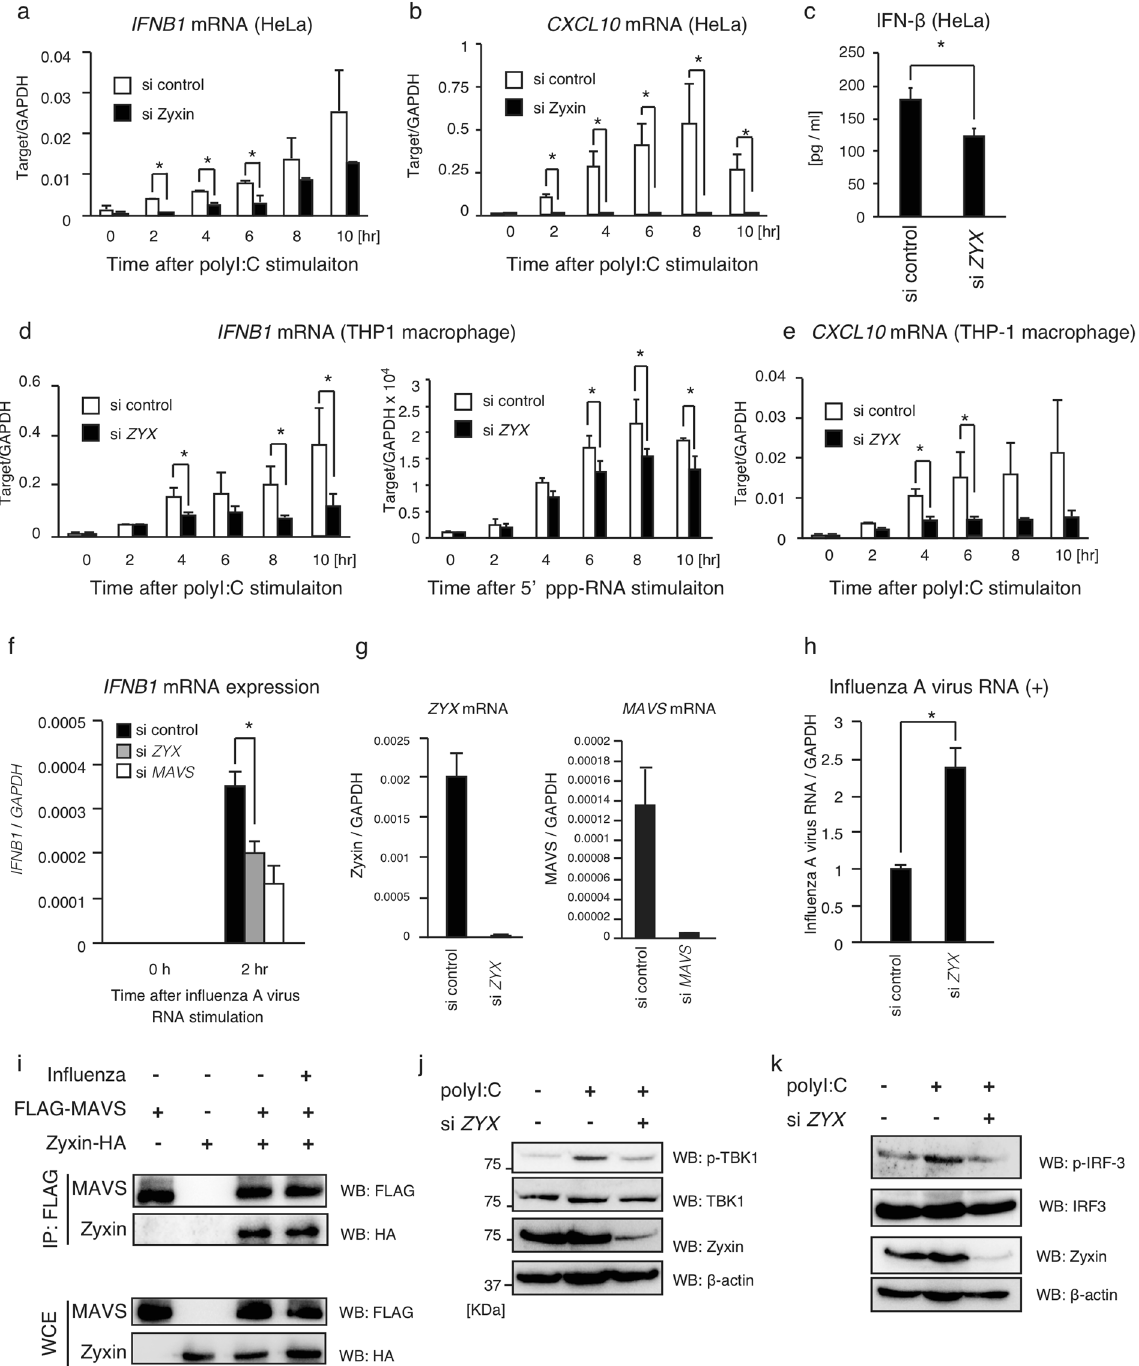
Figure 4. Zyxin is involved in a type I IFN expression pathway. ( a , b ) siRNA for ZYX or negative control were transfected into HeLa cells. Two d. after transfection, cells were transfected with polyI:C. Total RNA was extracted at the indicated time points. IFNB1 and CXCL10 mRNA expressions was determined by qPCR and normalized to GAPDH . The data represent means ± SD. They are representative of at least 2 independent experiments. * p < 0.05 (n = 3, t-test). ( c ) siRNA for ZYX or negative control was transfected into HeLa cells for 2 d. Cells were transfected with polyI:C for 24 h. IFN- β protein levels in cell culture medium were determined by ELISA. The data represent means ± SD. They are representative of 2 independent experiments. * p < 0.05 (n = 3, t-test). ( d , e ) siRNA for ZYX or negative control were transfected into THP-1 cells. Two d after transfection, cells were transfected with polyI:C or 5 ′ ppp-RNA. Total RNA was extracted at the indicated time points. IFNB1 and CXCL10 mRNA expressions was determined by qPCR and normalized to GAPDH . The data represent means ± SD. They are representative of at least 2 independent experiments. * p < 0.05 (n = 3, t-test). ( f , g ) siRNA for negative control, ZYX and MAVS were transfected into HeLa cells for 2 d. Cells were transfected with in vitro -synthesized influenza A virus RNA.